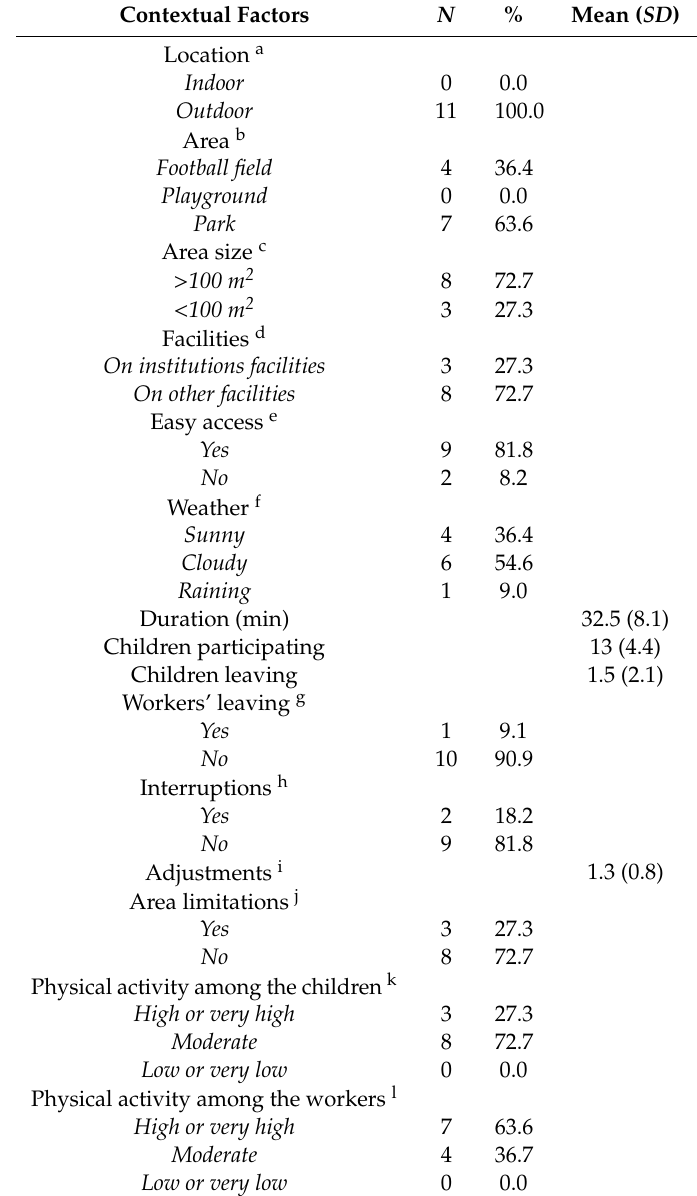
Table 3. Researcher observations during the Goldilocks-games ( N = 11